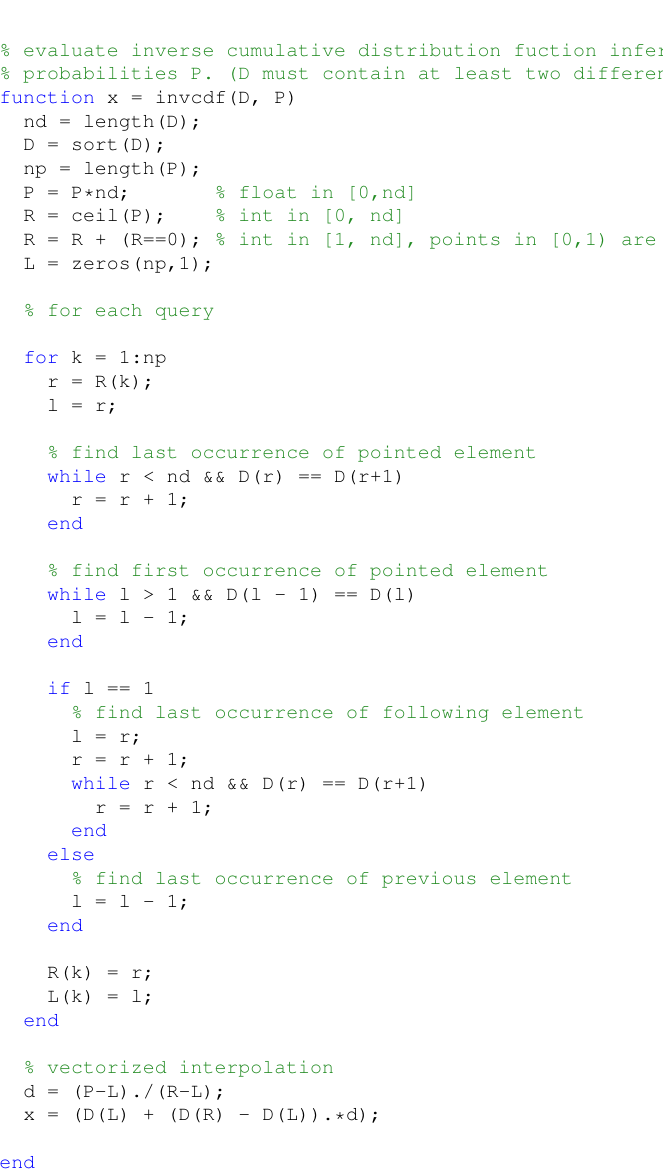
Figure A2. MATLAB code used to implement the INV C DF function.